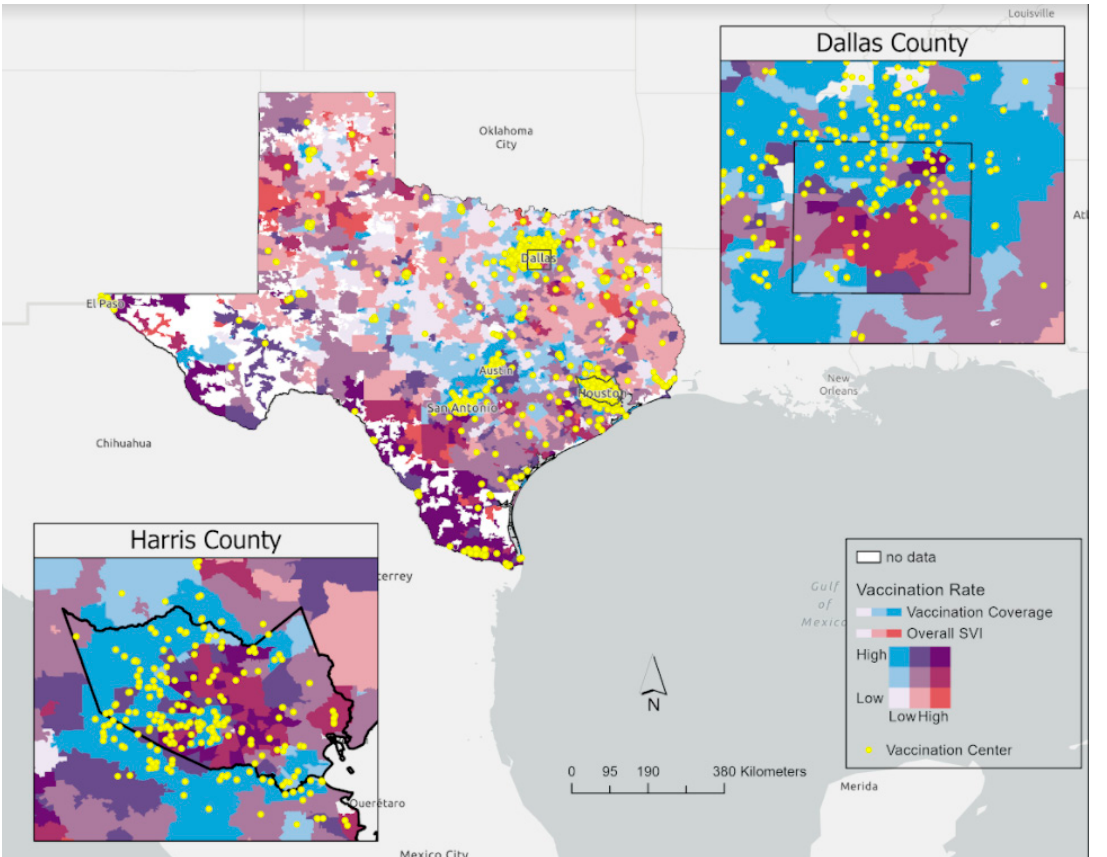
Figure 1. A sequential – sequential bivariate map to visualize the overall SVI against the vaccination coverage in Texas overlaid by vaccination center location. The color of the ZIP codes indicates the relationship between vaccination coverage and overall SVI ranking, where the red color indicates ZIP codes with higher scores for overall SVI and low vaccine-uptake rates. In contrast, the blue color represents ZIP codes with high vaccine coverage and low overall SVI. The yellow dots represent the vaccination centers.